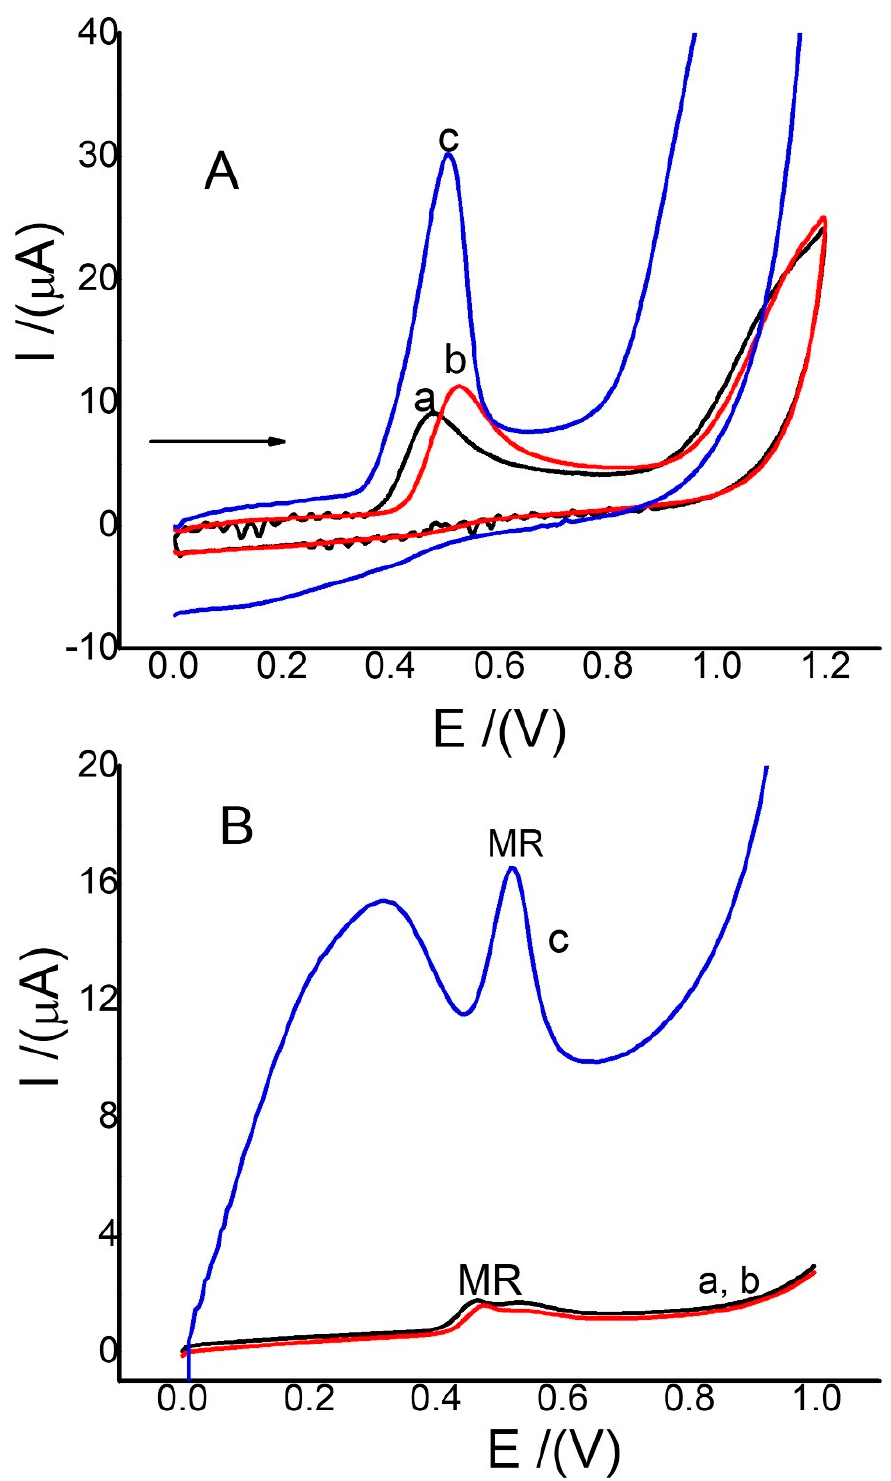
Figure 2. ( A ) CVs of MR (0.12 mmol/L) using GCE (curve a, black), Ch/GCE (curve b, red), and Ch-G/GCE (curve c, blue) at a scan rate of 0.1 V/s; and ( B ) SWVs of MR (6.0 µmol/L) with GCE (curve a, black), Ch/GCE (curve b, red,), and Ch-G/GCFE (curve c, blue). Conditions: pH 3.0 (phosphate-buffered solution) at 0.0 V for 30 s, frequency 15 Hz, amplitude 0.05 V, and potential increment 0.01 V.